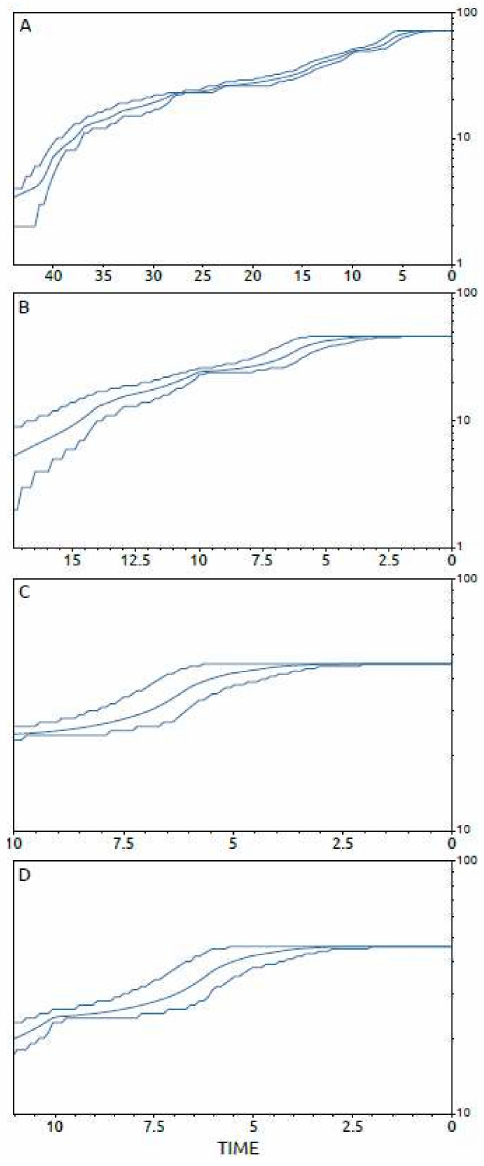
Figure 8. Number of ASFV lineages through time. Logarithmic expansion in the amount of viral lineages ( y -axis) is shown as a function of time from the present ( x -axis), with the units expressed in years. ( A ) ASFV whole Sardinia dataset; ( B ) dataset encompassing only Sardinian sequences included in cluster C of the phylogenetic tree; ( C ) dataset encompassing only Sardinian sequences included in sub-group C2 of the phylogenetic tree, and ( D ) dataset encompassing only Sardinian sequences included in sub-group C1 of the phylogenetic tree. The bold lines denote the median estimates and the grey lines denote the 95% high posterior density (HPD)